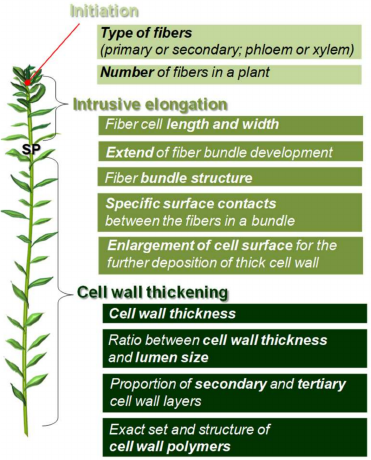
Figure 4. Impact of the key stages of primary bast fiber development on the quality-related parameters. SP-snap point (a marker of fiber developmental transition from elongation to cell wall